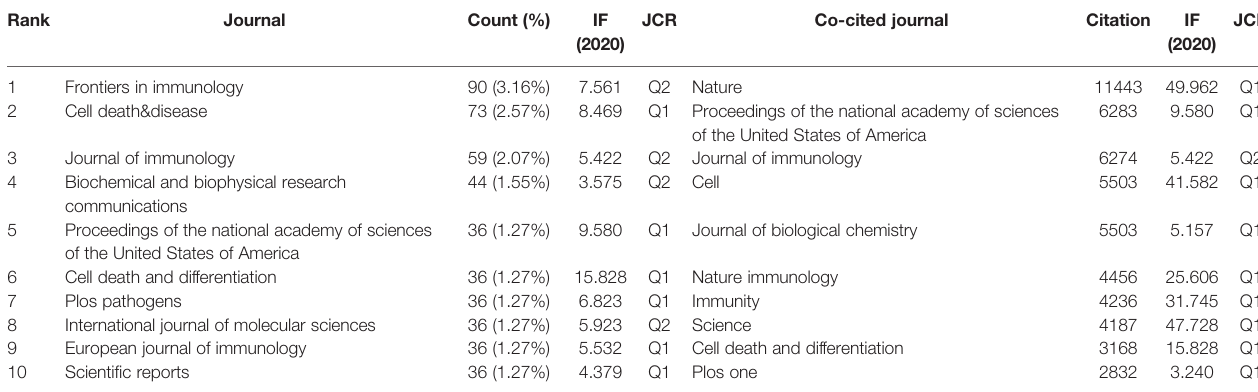
TABLE 3 | Top 10 journals and co-cited journals related to